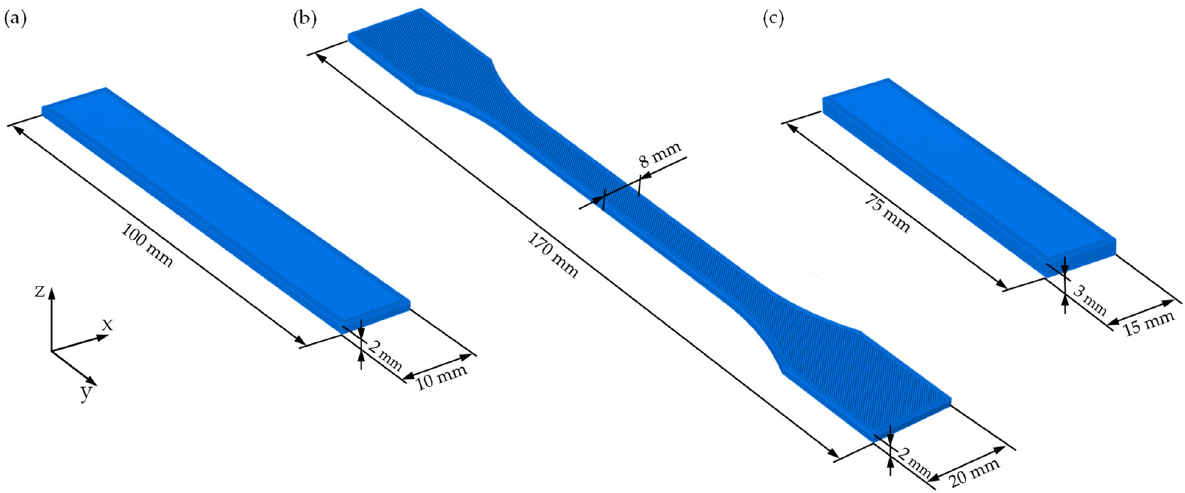
Figure 4. Dimensions of the specimens: ( a ) flexural specimen; ( b ) tensile specimen; ( c ) impact specimen. Table 2. Fiber volume fractions of the fabricated tensile, flexural and impact specimens. Specimen